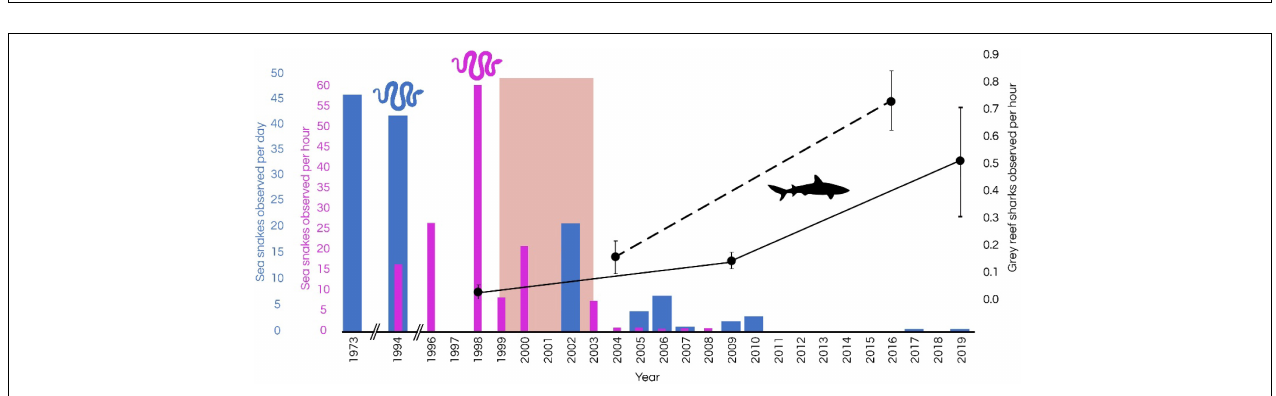
FIGURE 4 | Sharks’ fins (top panel) and strips of shark meat (bottom panel) being died on a traditional Indonesian fishing boat at Ashmore in 1987 [Photo Barry Russell, Northern Territory Museum; used with permission from Plate 4 of Russell and Vail (1988)].